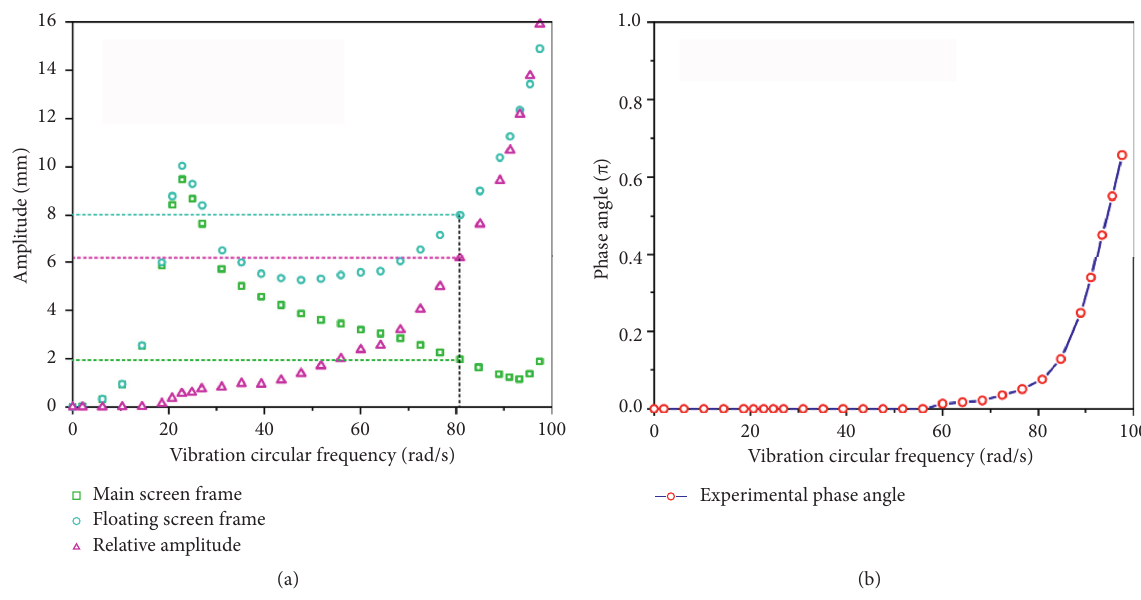
Figure 7: Experimental dynamic response of VFFS. (a) Amplitude. (b) Phase